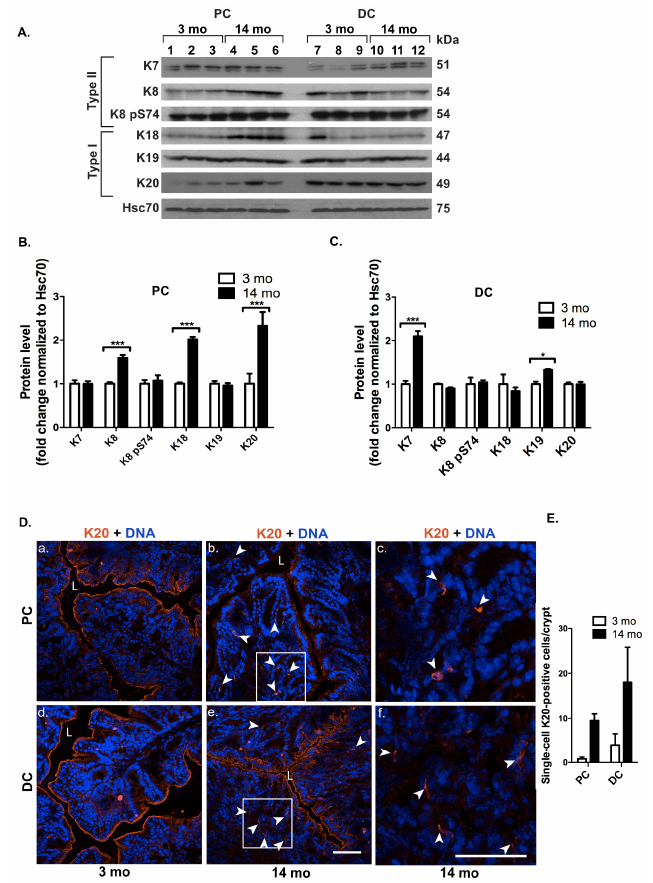
Figure 5. Ageing leads to upregulation of all colonic keratins in DC and PC in a differential manner. Proximal colon (PC) and distal colon (DC) keratin levels and distribution were analyzed in 3 and 14 months (mo) old mice ( n = 3 for 3 months old mice, lanes 1–3 and 7–9, n = 3 for 14 months old mice, lanes 4–5 and 10–12) by protein analysis and immunofluorescence staining. ( A – C ) Keratin Western blotting and quantification (normalized to loading control Hsc70) of colon lysates showed that K8, K18 and K20 were upregulated in PC, whereas K7 was highly and K19 slightly upregulated in DC. * p < 0.05, *** p < 0.001. ( D , E ) The K20 upregulation in novel single cells below the luminal epithelium in 14 months old mice was confirmed by immunofluorescence staining in PC (panel a–b, b magnified from boxed area in c, arrow heads) and DC (panel d–e, e magnified from boxed area in f, arrow heads) as broader localization in the crypts. Nuclei (DNA) are shown in blue. L = lumen, scale bars = 50 μ m. ( E ) The increased number of single-cell K20-positive cells/crypt in PC and DC of young and old mice is shown. N = 20 crypts. Numerical data are shown as average ± SD. Statistical significance for Western blot data was determined by